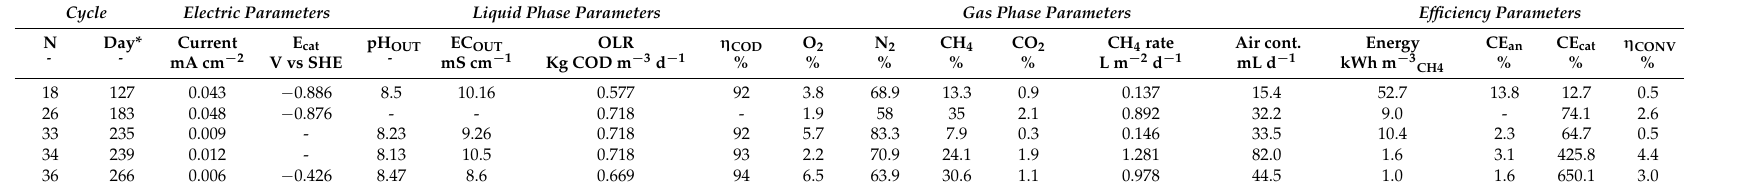
Table A6. Selection of five cycles for BES 2, operated at constant 0.7 V voltage with synthetic